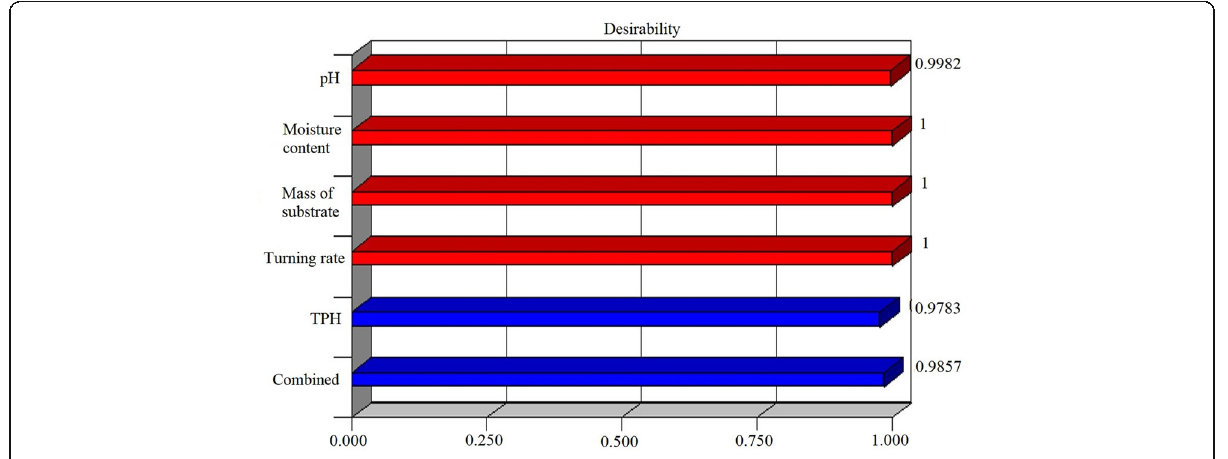
Fig. 8 Prediction accuracy of numerical